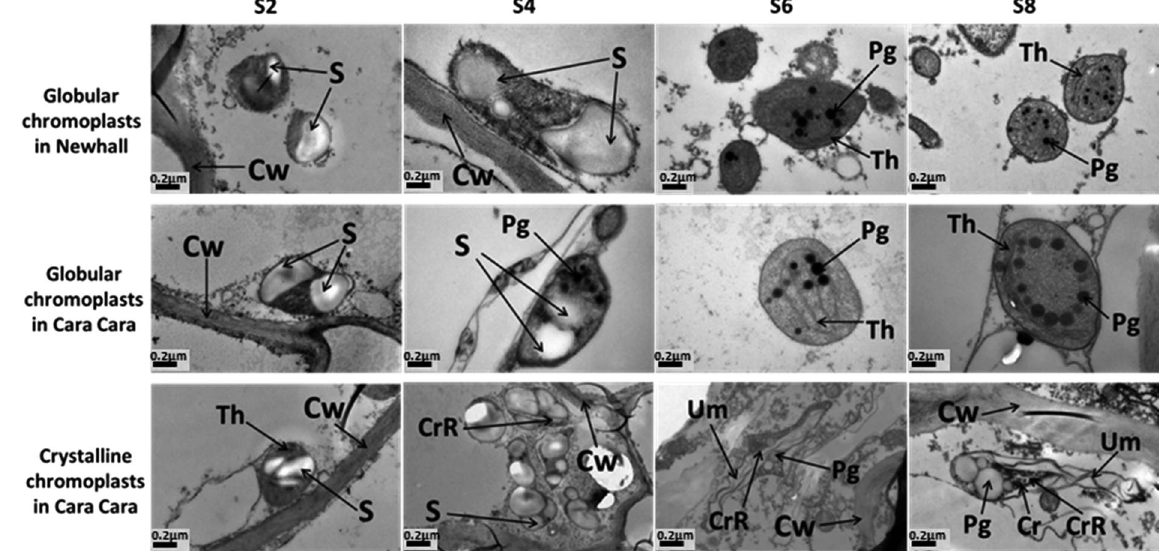
Figure 6. Ultrastructure of yellow globular chromoplast in Newhall, and yellow globular and red crystalline chromoplasts in Cara Cara viewed in the transmission electron microscope. Cr, crystal; CrR, crystalloid remnant; Cw, cell wall; Pg, plastoglobuli; S, starch; Th, thylakoid; UM, undulating